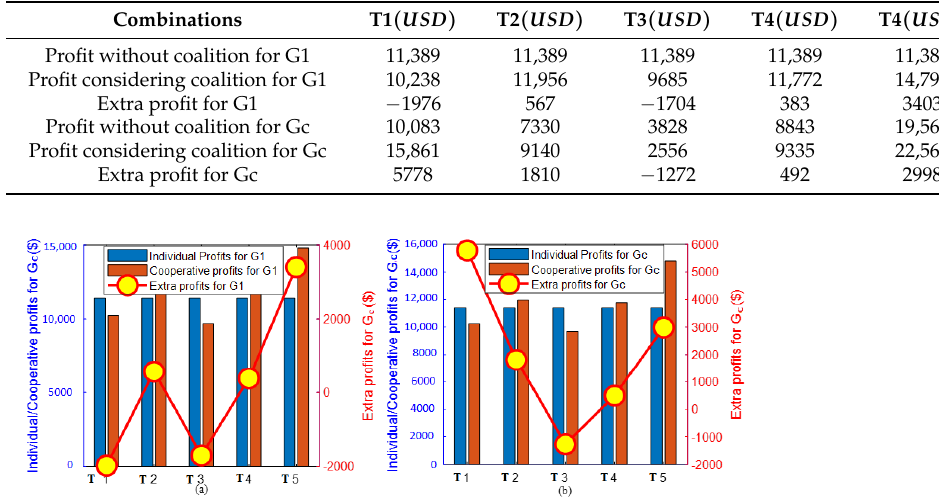
Figure 12. Different market profits of G1 supplier under completely individual bidding. Table 3. Comparison of profits with and without considering coalitions.